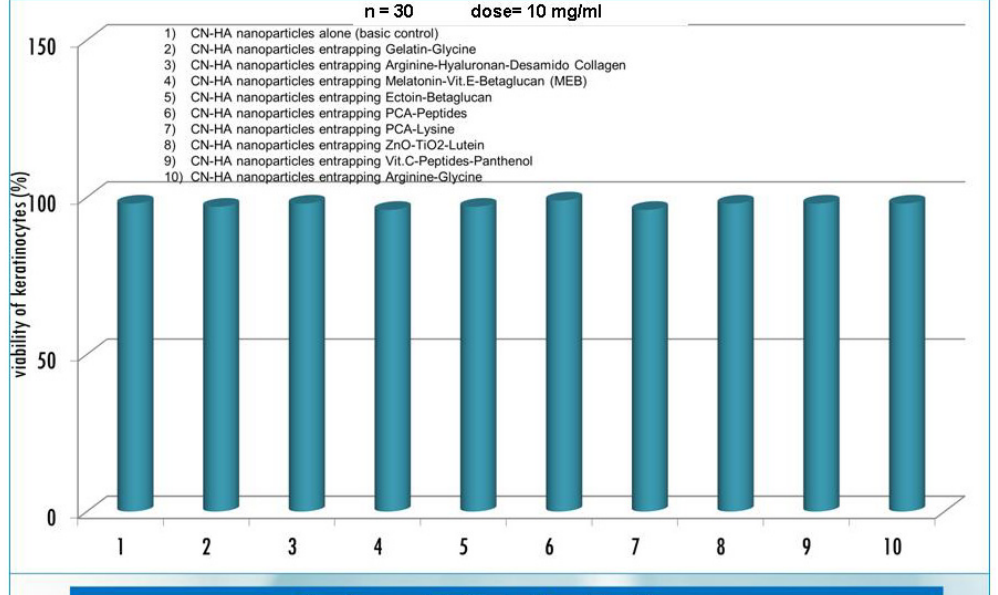
Figure 3. Effect of Chitin Nanofibril-Hyaluronan nanoparticles on the viability of keratinocytes. All p values are not significant as the control and the